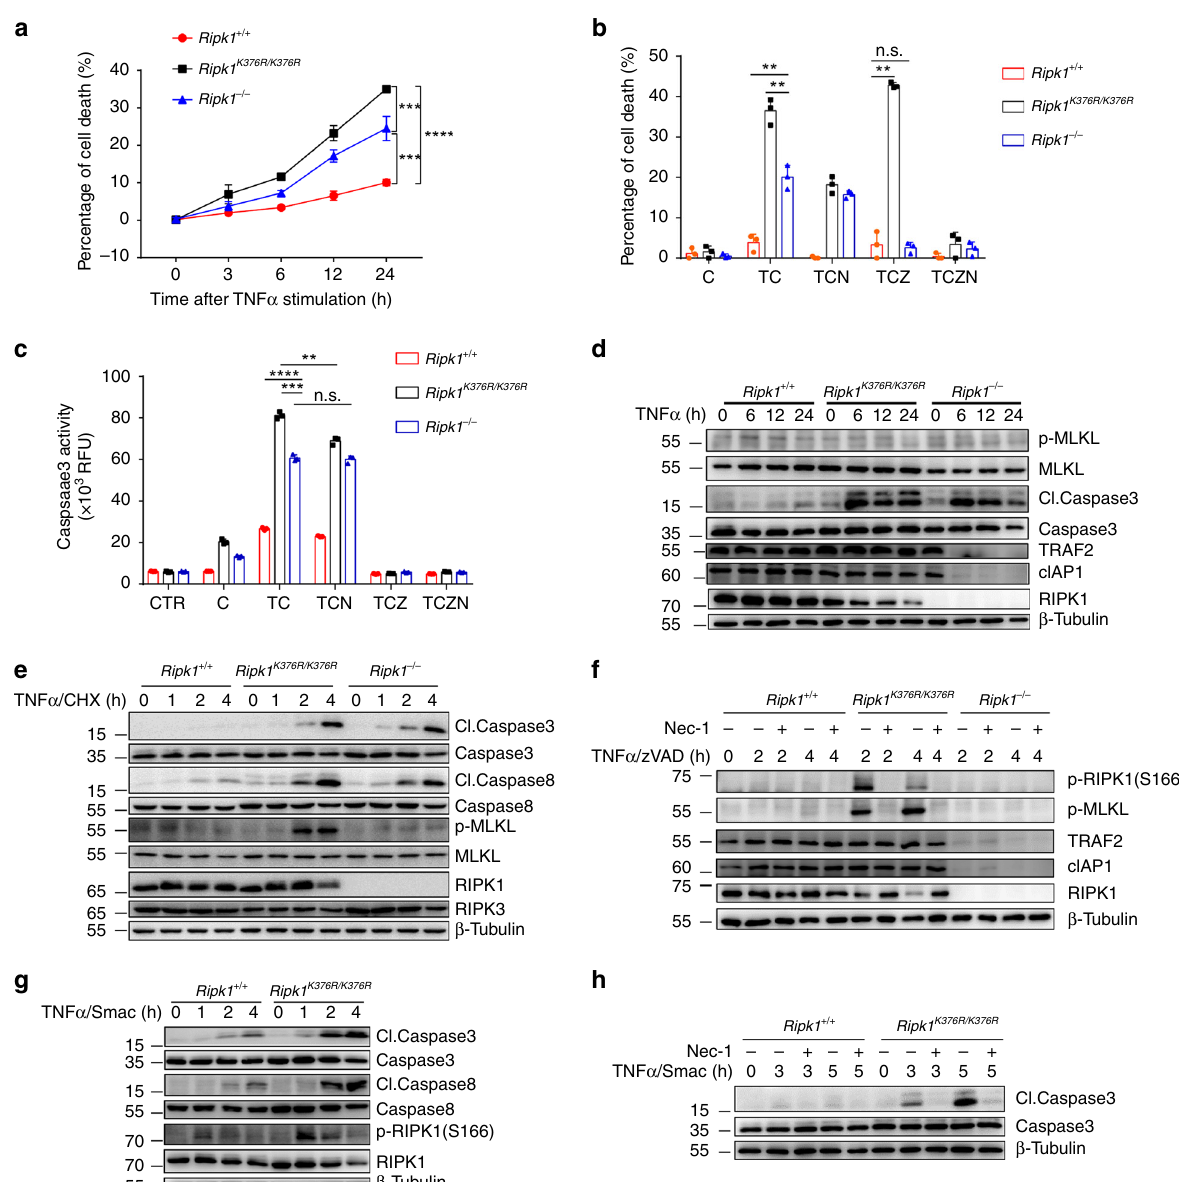
Fig. 2 Ripk1 K376R/K376R mutation sensitizes cells to apoptosis and necroptosis. a Cell death of immortalized Ripk1 + / + , Ripk1 K376R/K376R , and Ripk1 − / − MEFs treated with TNF α for different time point was measured by SytoxGreen positivity. b Cell death of immortalized Ripk1 + / + , Ripk1 K376R/K376R , and Ripk1 − / − MEFs treated for 5 h with different stimulators was measured by SytoxGreen positivity. T, TNF α ; C: cycloheximide (CHX); Z: zVAD.fmk; N: necrostatin-1. c Caspase3 activity of Ripk1 + / + , Ripk1 K376R/K376R , and Ripk1 − / − immortalized MEFs treated for 5 h with different stimulators were measured by DEVD-AMC fl uorescence. d – h Ripk1 + / + , Ripk1 K376R/K376R , and Ripk1 − / − immortalized MEFs were treated with TNF α ( d ), TNF α /CHX ( e ), TNF α / zVAD.fmk ( f ), or TNF α /Smac mimetics ( g , h ) with or without pre-treatment of necrostatin-1 for the indicated time, and the cell lysates were analyzed by western blotting using the indicated antibodies. In a – h , TNF α , 20 ng/ml; CHX: 10 μ g/ml; zVAD.fmk, 20 μ M; Smac mimetics, 5 μ M; necrostatin-1, 10 μ M. In a – c , data are mean ± s.e.m. ( n = 3 independent cell samples for each genotype). Statistical signi fi cance was determined using a two-tailed unpaired t test, n.s., P >